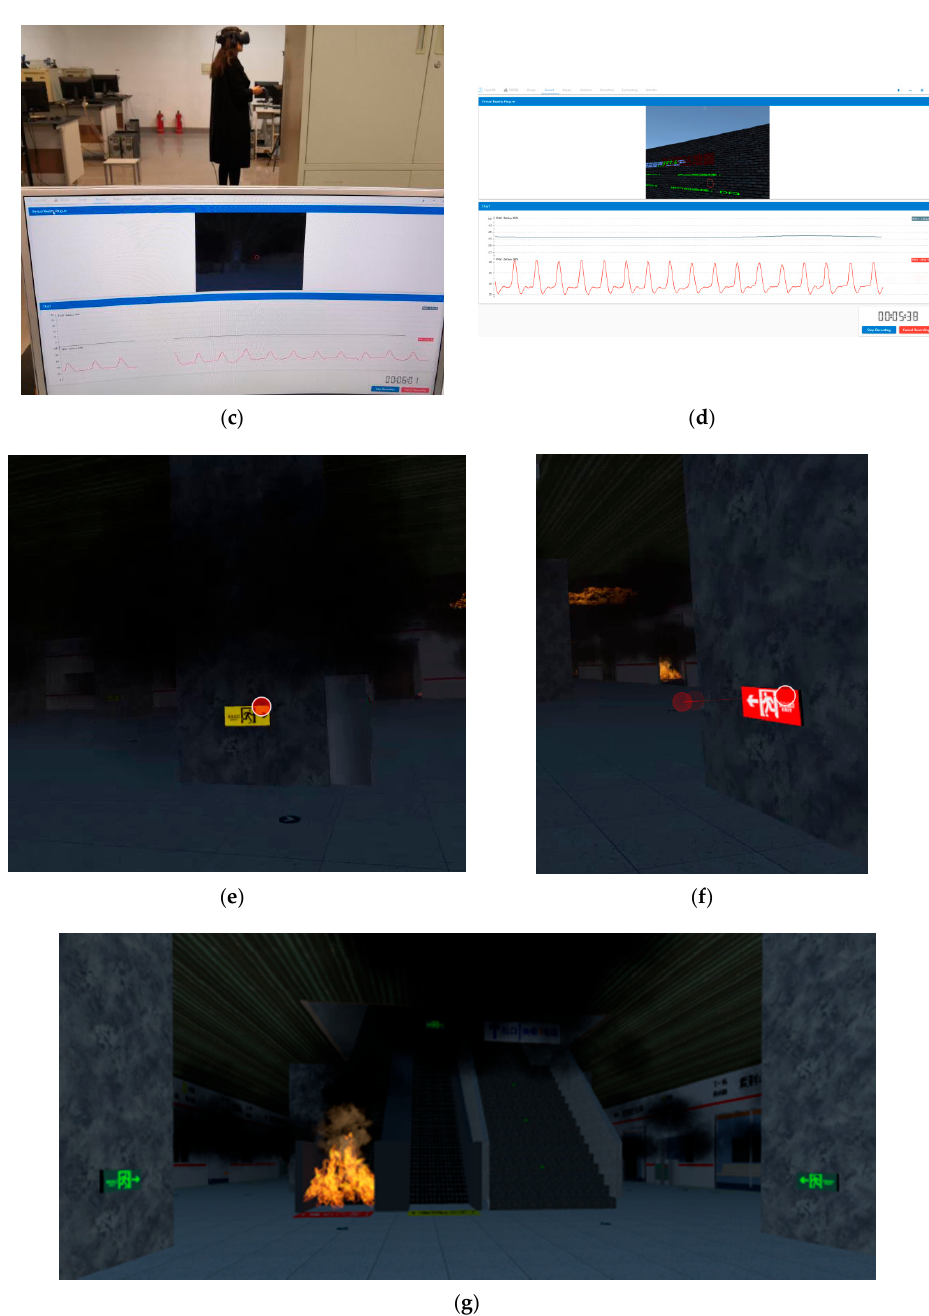
Figure 6. ( a ) One of the participants wore EDA sensor and PPG sensor in stable status in the baseline period; data were real-time recorded for 2 min. ( b ) One of the participants wore HTC Vive Pro Eye helmet, with a HTC trackpad in her hand; meanwhile EDA sensor and PPG sensor were put on her fingers and earlobe, during the virtual fire escape period. ( c , d ) Physiological data and eye-tracking data were real-time recorded by ErgoLAB V3.0, in the entire baseline period and the whole fire escape period. ( e , f ) When participants’ fixation points fell in the AOI (Area of Interest) of safety signs, the related eye-tracking data would be recorded; ( g ) Screenshots of the constructed virtual Zijing Mountain subway fire escape scene in Unity3D (1:1 scale of the real Zijing Mountain subway